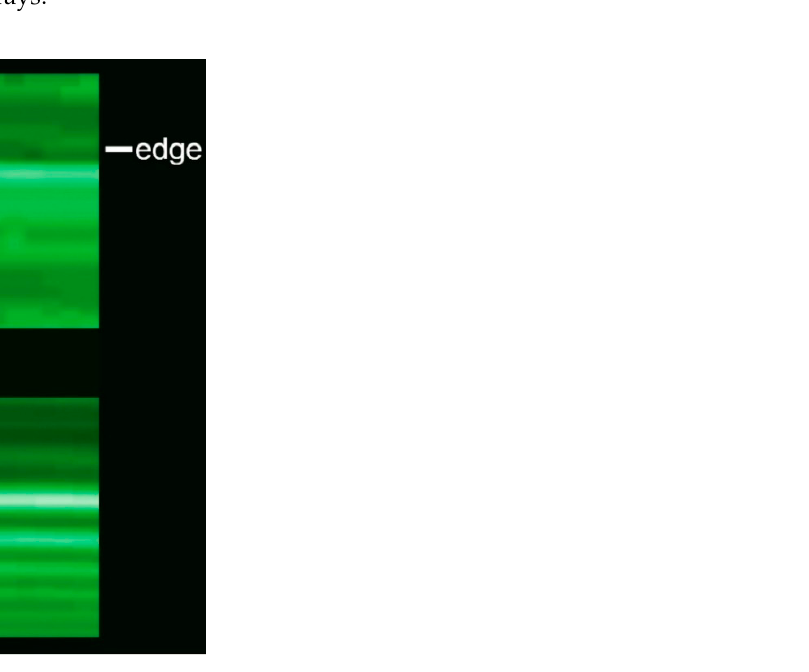
Figure 8. Left: refraction of X-rays passing through a slanted edge between an object and vacuum cause a characteristic pair of bright-fark fringes. A similar phenomenon occurs for a slanted edge separating two different object regions. Top right: analysis of the fringe geometry. Bottom right: enlarged scheme of the edge showing the parameters used ion the analysis.